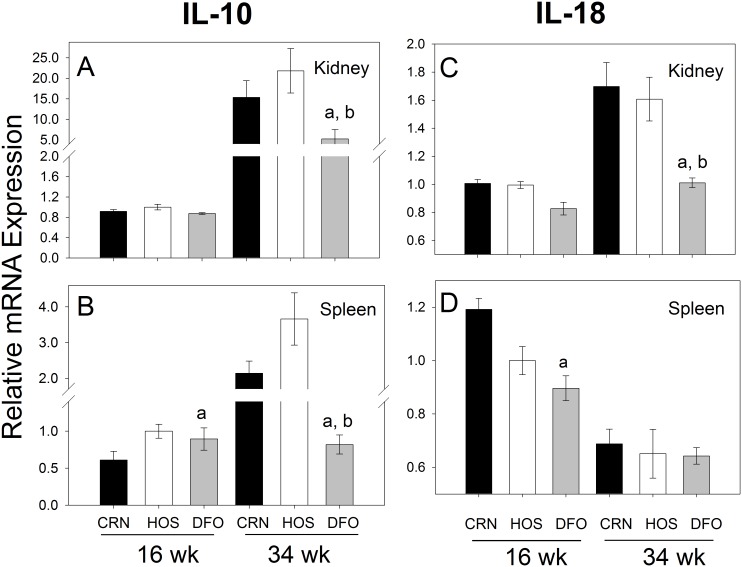
Differential effects of n-3, n-6 and n-9 PUFA consumption on IL-10 and IL-18 mRNA expression.Experiment conducted as described in Fig. 7 legend except that IL-10 (A, B) and IL-18 (C, D) mRNAs were measured by quantitative RT-PCR.